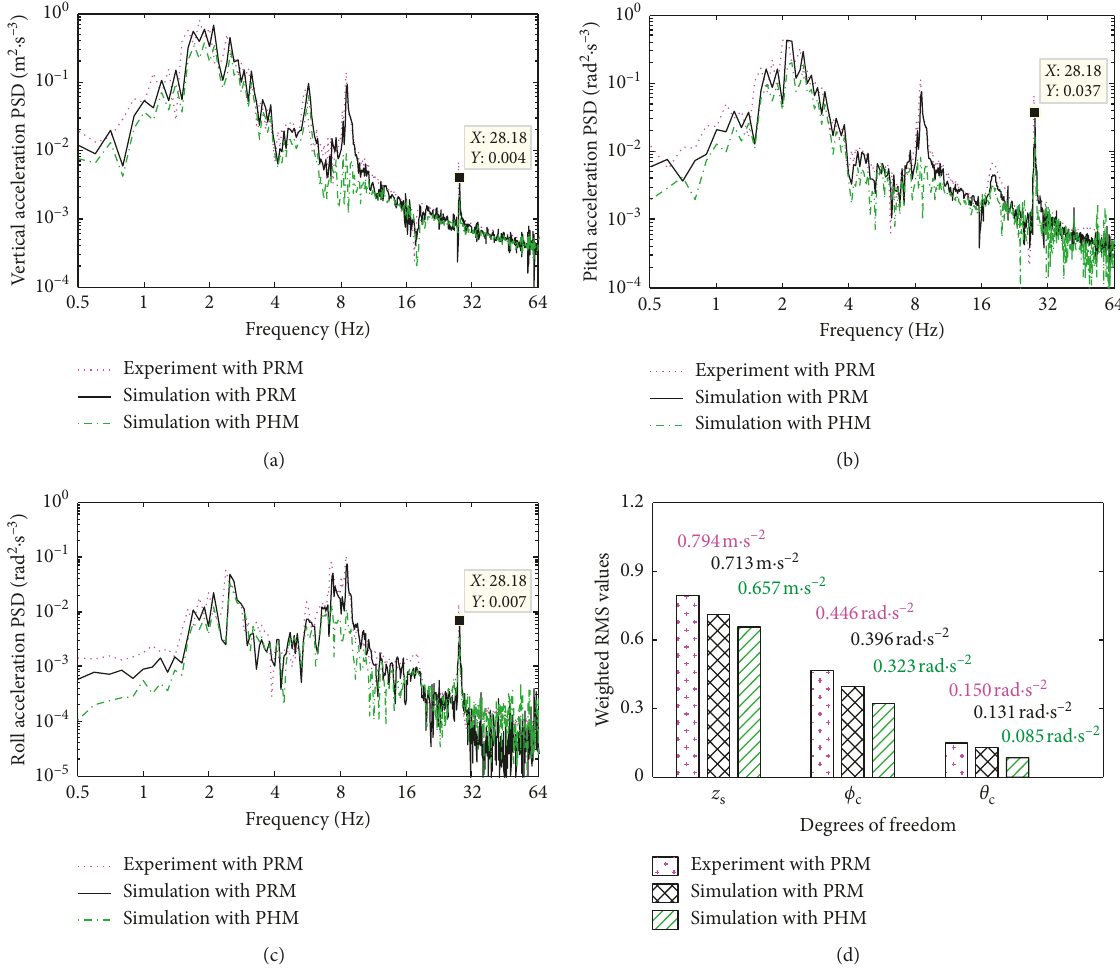
Figure 4: The experimental and simulation results under an excitation frequency 28Hz of the drum [1]. (a) PSD acceleration response of the vertical driver’s seat. (b) PSD acceleration response of the cab’s pitch angle. (c) PSD acceleration response of the cab’s roll angle. (d) Weighted RMS values of the driver’s seat and the